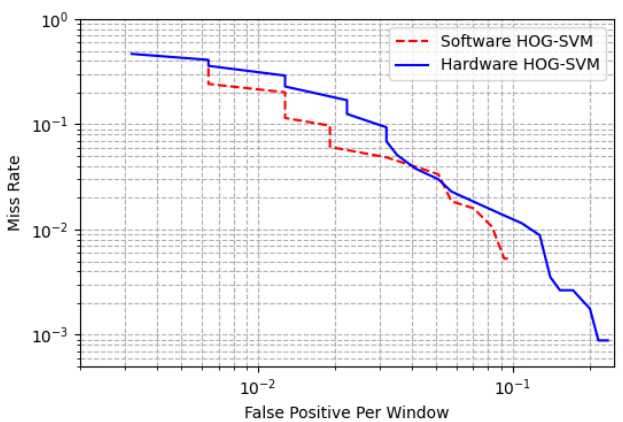
Figure 17. Comparison of software implementation and our proposed HW-SW co-design.